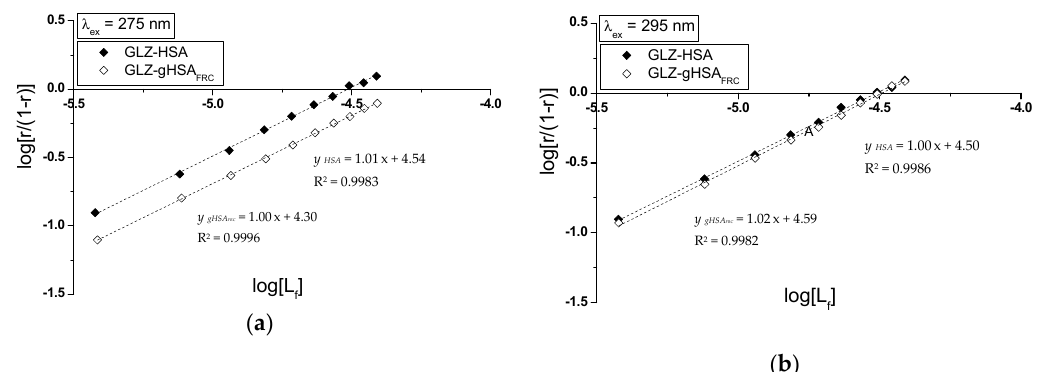
Figure 10. The Hill curves for GLZ-HSA and GLZ-gHSA FRC . ( a ) λ ex = 275 nm and ( b ) λ ex = 295 nm; the error bars are smaller than the symbols.